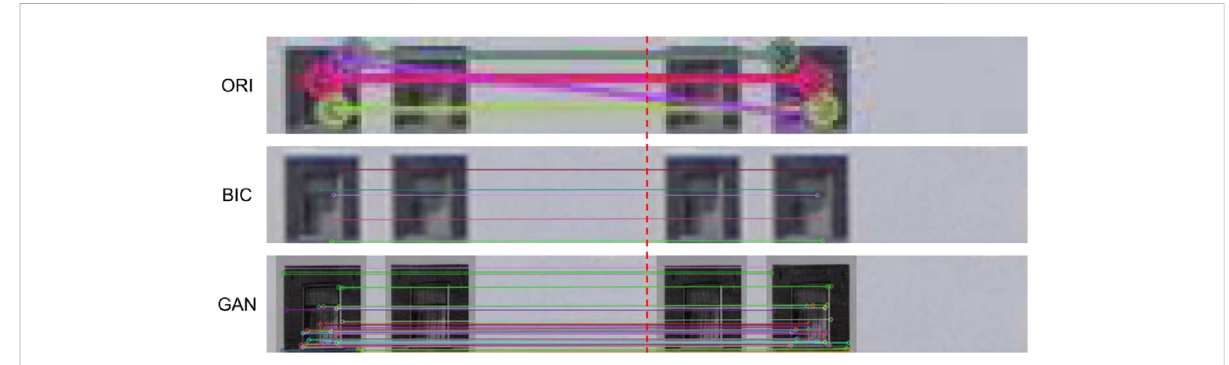
FIGURE 18 Results of the SIFT feature point detection and matching after increasing the resolution of images with ORI, BIC, and GAN. The left images on the left half are the source images, and the right images on the right half are the destination images (Sun et al.,